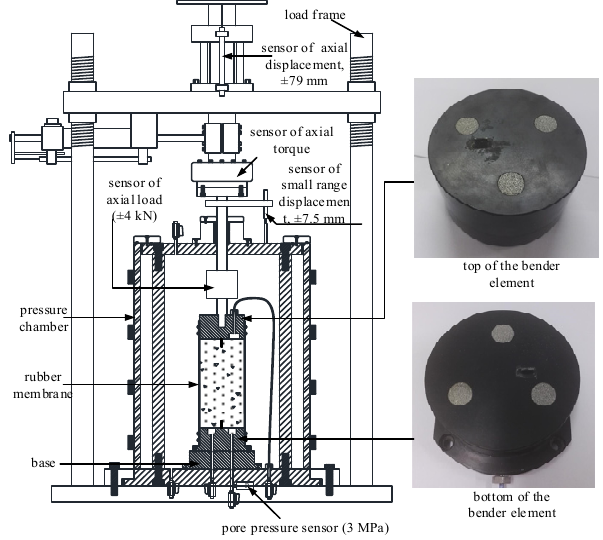
Figure 1. Bender element test apparatus.